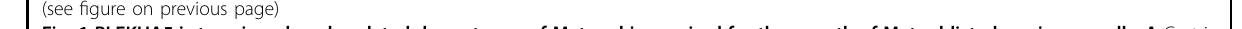
Fig. 1 PLEKHA5 is tyrosine-phosphorylated downstream of Met and is required for the growth of Met-addicted carcinoma cells. A Gastric carcinoma cell lines were subjected to immunoprecipitation with an anti-phosphotyrosine (pTyr) antibody followed by immunoblotting with an anti- PLEKHA5 antibody. B 58As9 diffuse-type gastric carcinoma (DGC) cells and EBC-1 lung carcinoma cells were treated with Met inhibitors PHA-665752 (PHA) or JNJ-38877605 (JNJ) at 300 nM for 2 h and subjected to immunoprecipitation with anti-PLEKHA5 antibody and immunoblotting. C MKN45 DGC cells were treated with Met inhibitors, PHA, JNJ, or PF-2341066 (PF) at 300 nM, and the Src inhibitor saracatinib or EGFR inhibitor AG1478 at 10 µM for 2 h, and then subjected to immunoprecipitation and immunoblotting. D 58As9 and MKN45 cells were transfected with Met siRNAs and then subjected to immunoprecipitation and immunoblotting. E Tyrosine phosphorylation and expression of PLEKHA5 and Met in a panel of normal and cancerous cell lines were examined by immunoprecipitation and immunoblotting. F The correlation between phosphorylation and expression of PLEKHA5 and Met was examined by quantitative analysis of the immunoblotting data and evaluated with Pearson ’ s correlation coef fi cient. G 58As9 cells transfected with Met or PLEKHA5 siRNAs for 48 h were analyzed by immunoblotting. H Morphology of cells transfected with the indicated siRNAs. I Time-course of cell viability after Met or PLEKHA5 siRNA transfection in 58As9 cells. Bars, SD ( n = 4). * P < 0.001; and ** P < 0.0001. J Diffuse- type gastric carcinoma (58As9, MKN45, NUGC-4, KATO-III), intestinal-type gastric carcinoma (IM95), lung carcinoma (EBC-1 and A549), and normal mesothelial (Met5A) cell lines were transfected with Met or PLEKHA5 siRNAs and their viability was examined at 6 days after transfection. Of these, 58As9, MKN45, and EBC-1 cells have Met gene ampli fi cation. Bars, SD ( n = 5 for 58As9, 4 for KATO-III, and 3 for others). * P < 0.01; ** P < 0.005; and *** P <